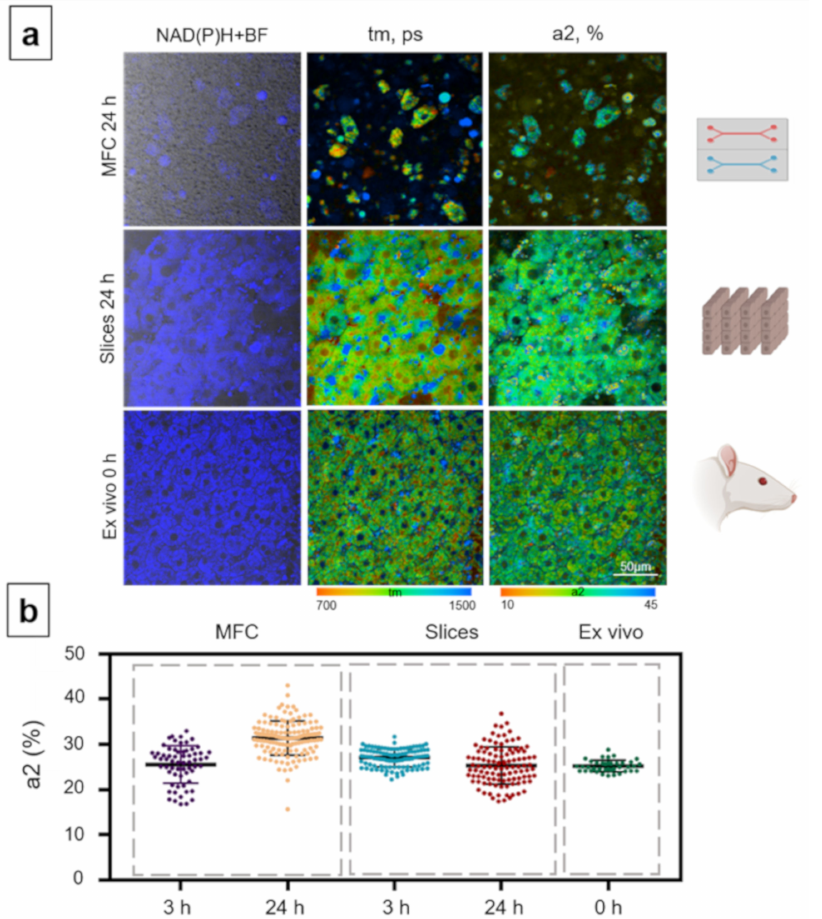
Figure 5. Metabolic imaging of control rat hepatocytes for the MFC, slice and ex vivo models. ( a ) Com- bined images of the bright-field and autofluorescence of NAD(P)H (left row) with pseudocolor- coded FLIM images of the NAD(P)H of the hepatocytes (central and right rows), field of view is 213 × 213 µ m; ( b ) scatter plots reflecting the distribution of the values of the fluorescence lifetime contributions of the bound form of NAD(P)H. Here, tm (ps) is the amplitude-weighted mean lifetime (tm); a2 (%) is the relative contribution of the bound form of NAD(P)H; scale bar: 50 µ